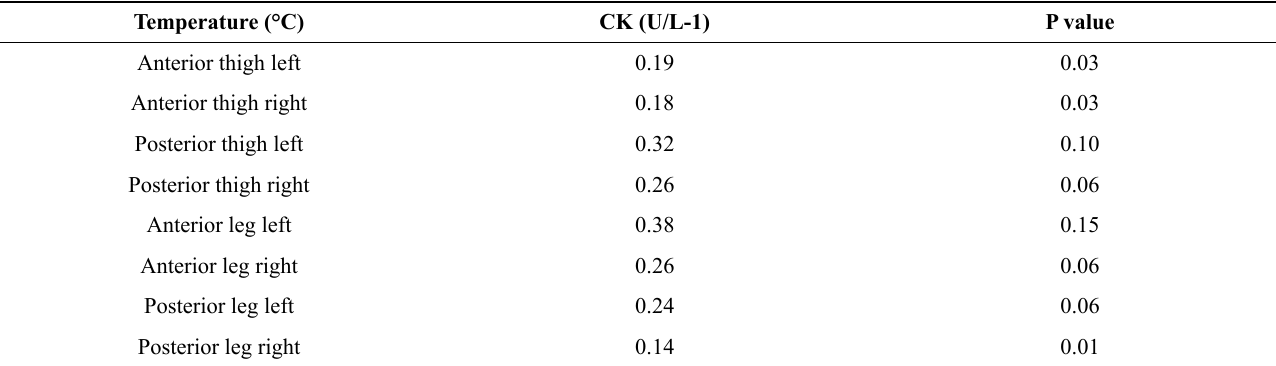
Table 1. Results of correlations among the variables: skin temperature Temperature (°C)